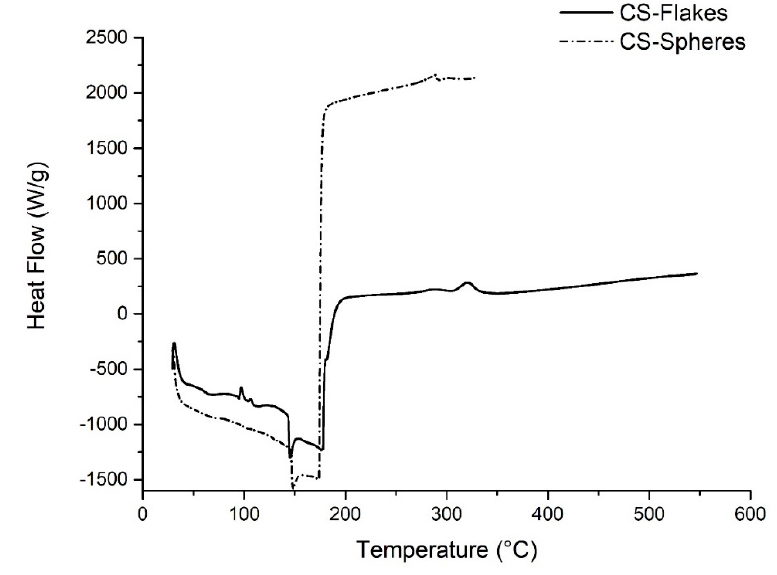
Figure 7. DSC analysis for CS flakes and spheres.